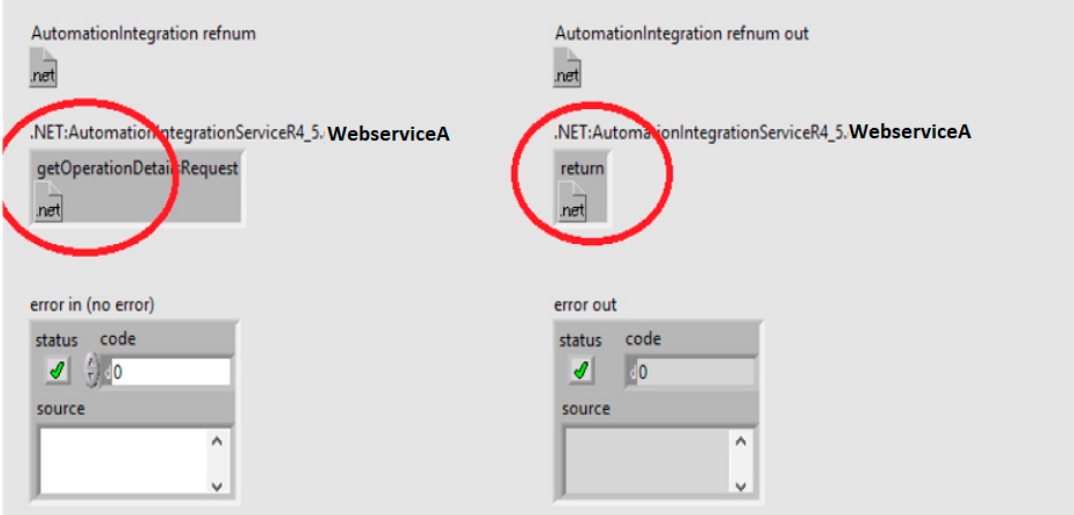
Figure 4. Front panel of ‘ WebserviceA ’ webservice (before edits).